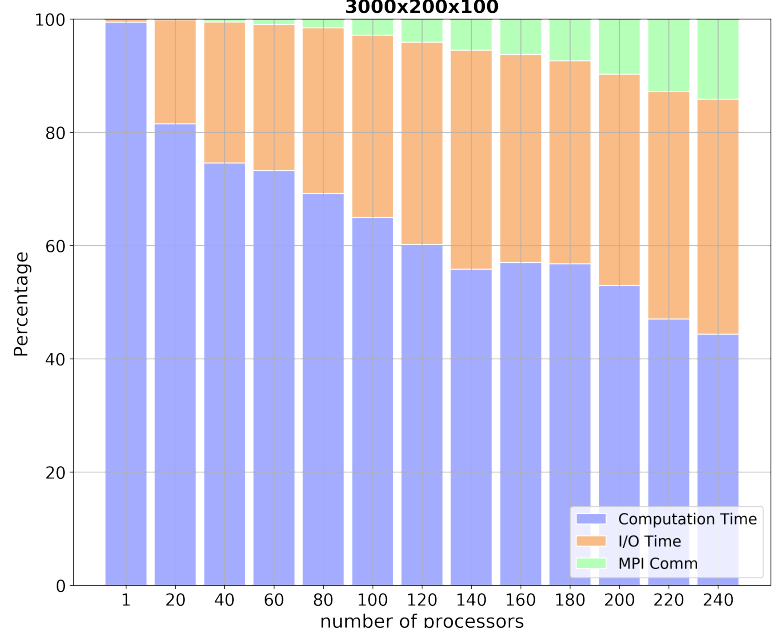
Figure 5. The histogram above shows a stacked normalized plot of the time partitioning between computation, I/O operations and estimated communication times as a function of processors for the high resolution problem.